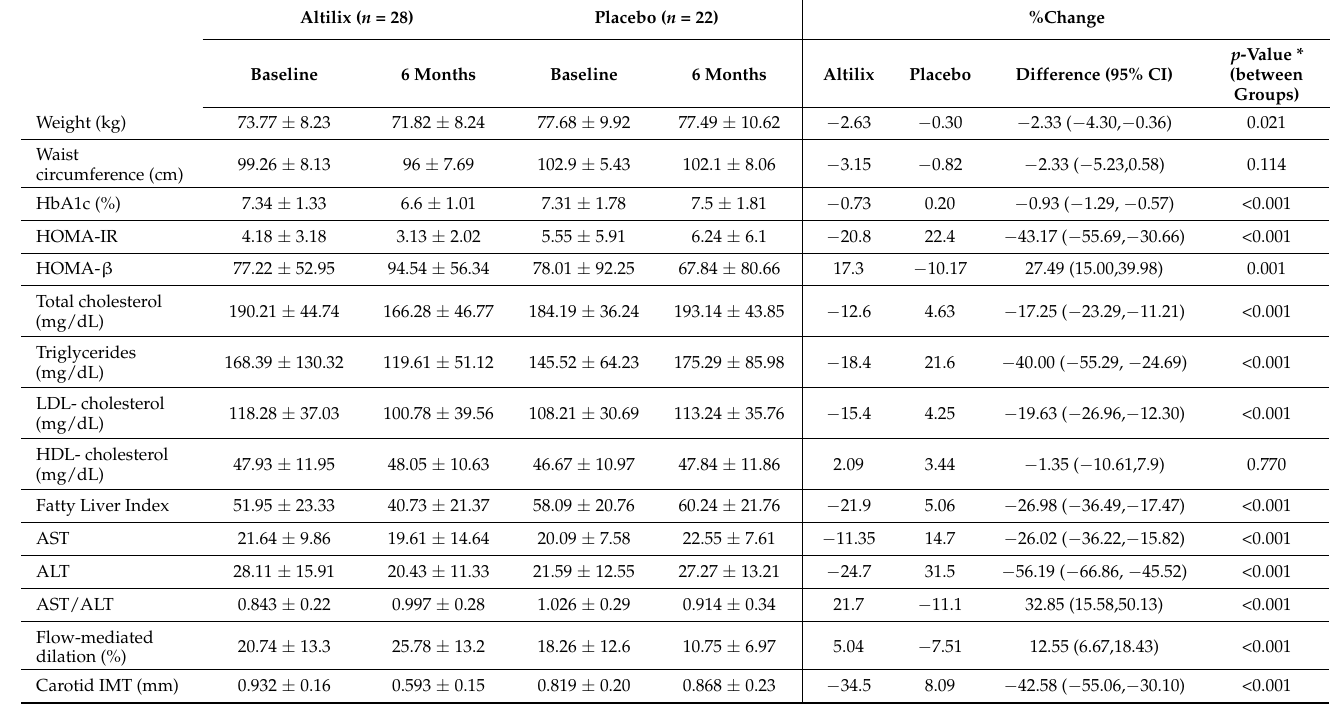
Table 1. Anthropometric, metabolic and cardiovascular profile of study